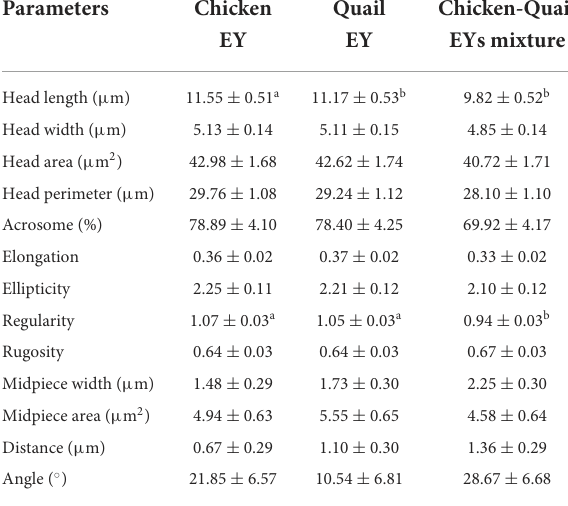
TABLE 4 Effects of adding and combining egg yolks (EY) of chicken and/or quail to the Tris glycerol extender on motility, vitality, plasma membrane integrity, DNA integrity and abnormalities of ram sperm post-thawing.